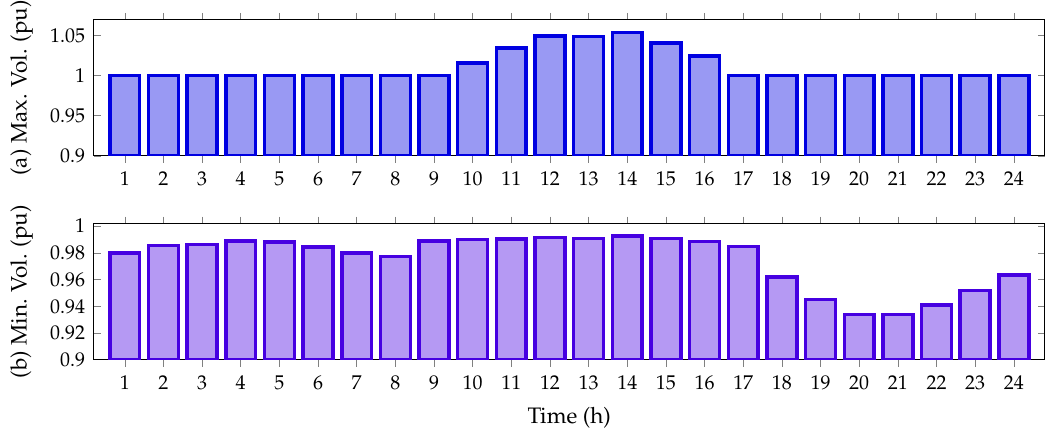
Figure 11. Voltage behavior during the day for the IEEE 33-bus system in its DC version: ( a ) maximum voltage magnitude and ( b ) minimum voltage